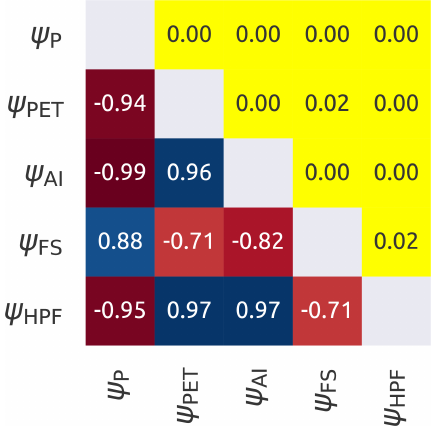
Figure 3. Internal correlation between the climatic indices. The lower triangle shows Spearman’s rank score with the red colour that indicates negative correlations and the blue that indicates positive correlations. The upper triangle reports the corresponding p values, where yellow colour indicates a statistically significant correlation ( p value < 0.05). The symbols used in the figure are reported in Ta- ble